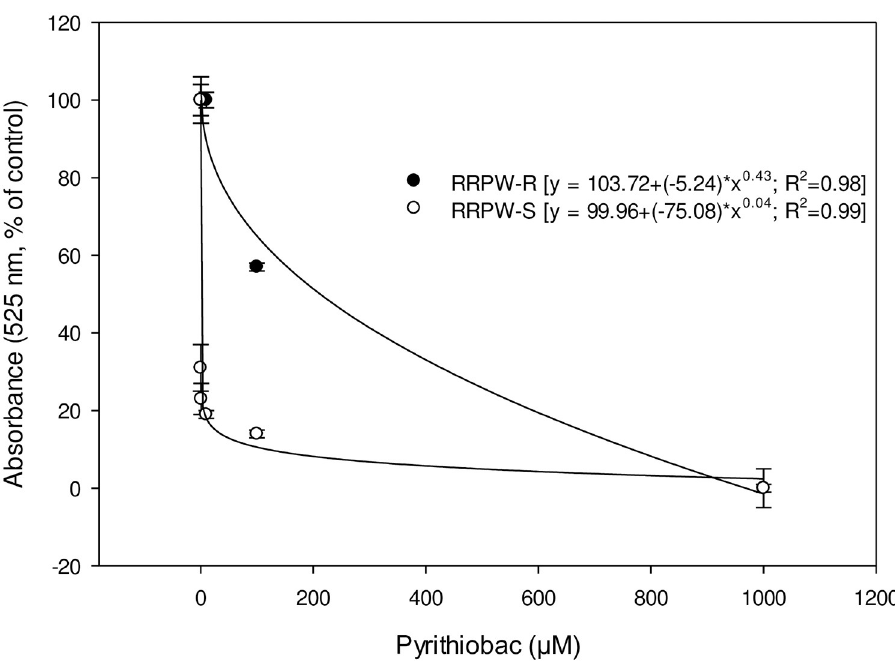
Fig 7. Pyrithiobac dose response ALS enzyme activity of ALS-inhibiting herbicide-resistant (RRPW-R) and -susceptible (RRPW-S) Amaranthus retroflexus populations from Mississippi. Vertical bars represent standard error of mean.